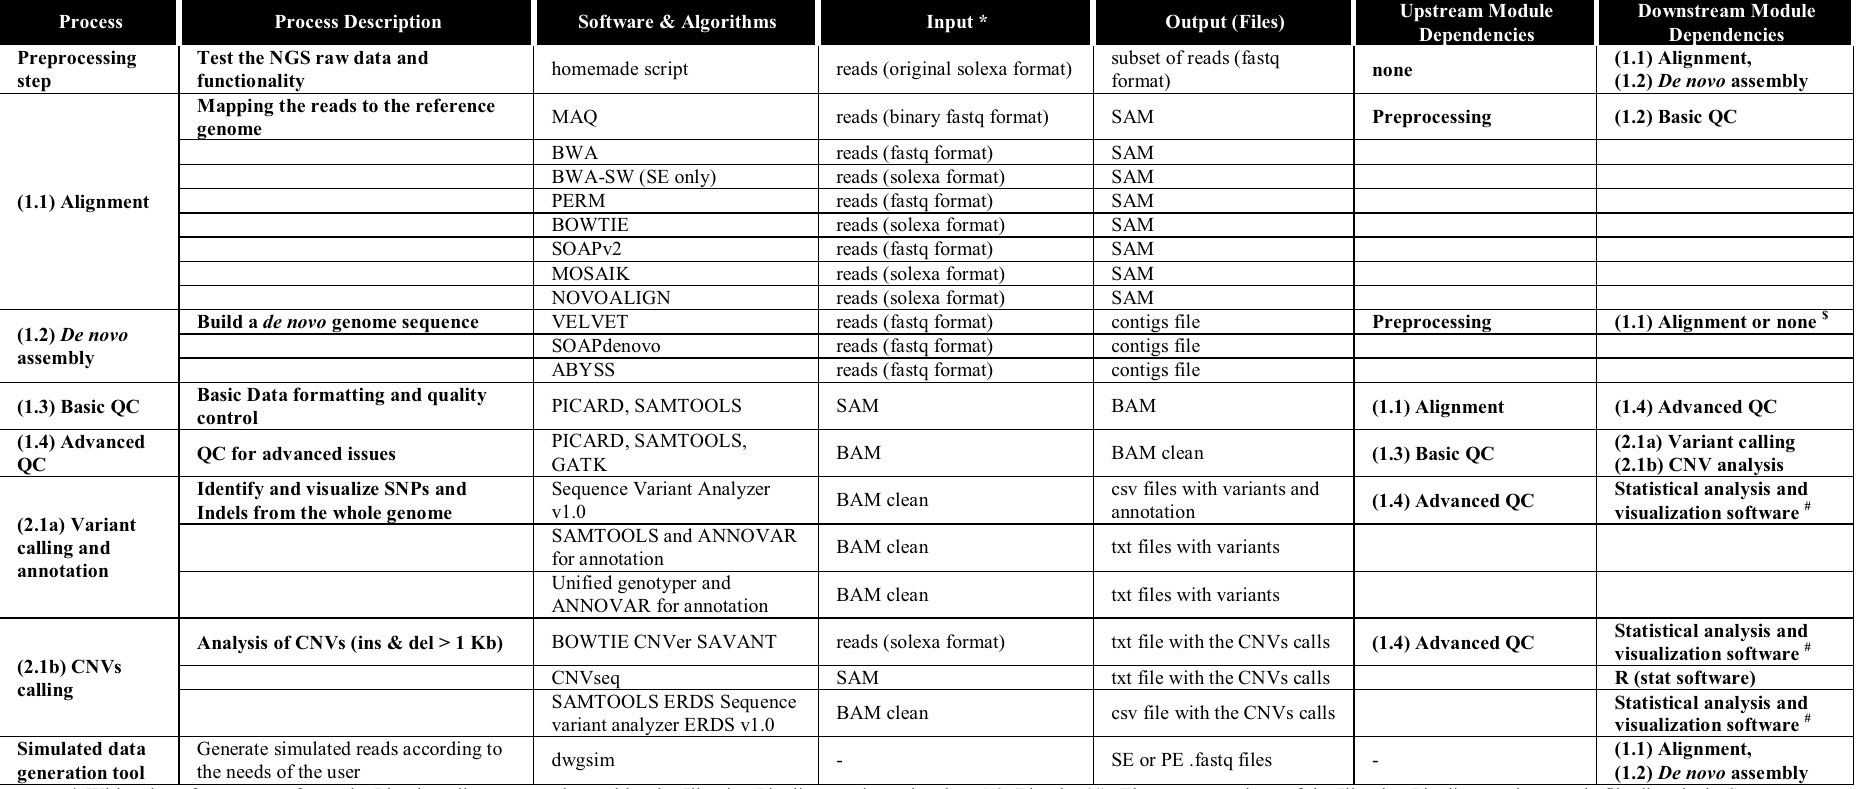
Table 3. Review of the processes and related workflows currently implemented in the NGS Pipeline. All processes and workflows have been tested and validated and are available for use by interested scientists. A single pipeline can be run independently from others, or can be connected as illustrated by the analytical workflow protocols described in this